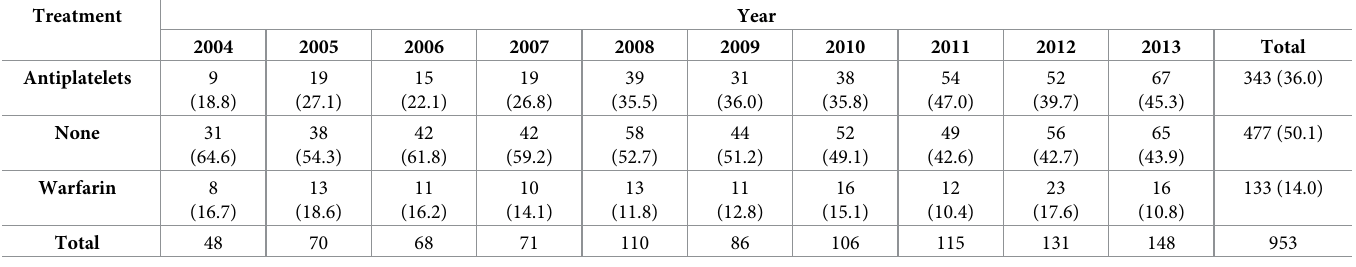
Table 3. Preadmission antithrombotic therapy in OAC therapy candidates � . Treatment